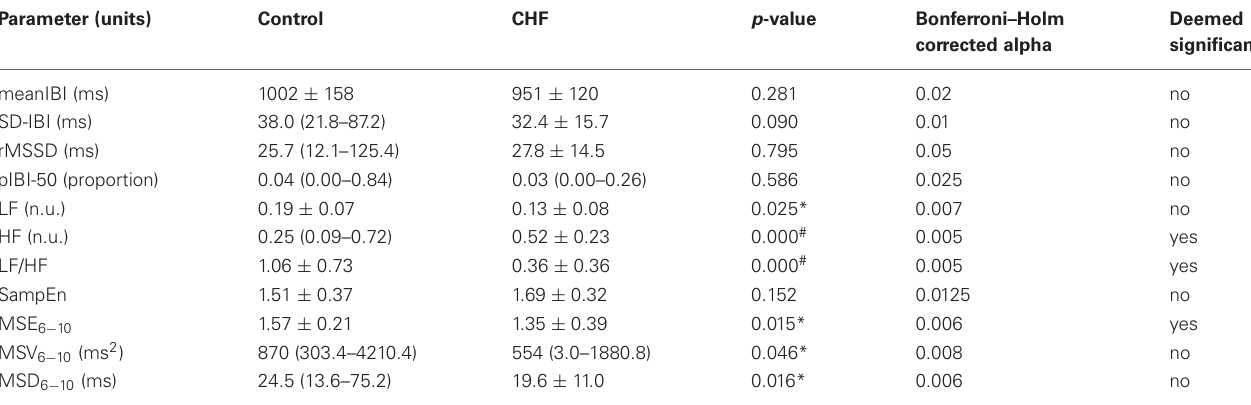
Table 1 | Parameter comparison between control subjects and CHF patients in 10-min supine posture. Parameter